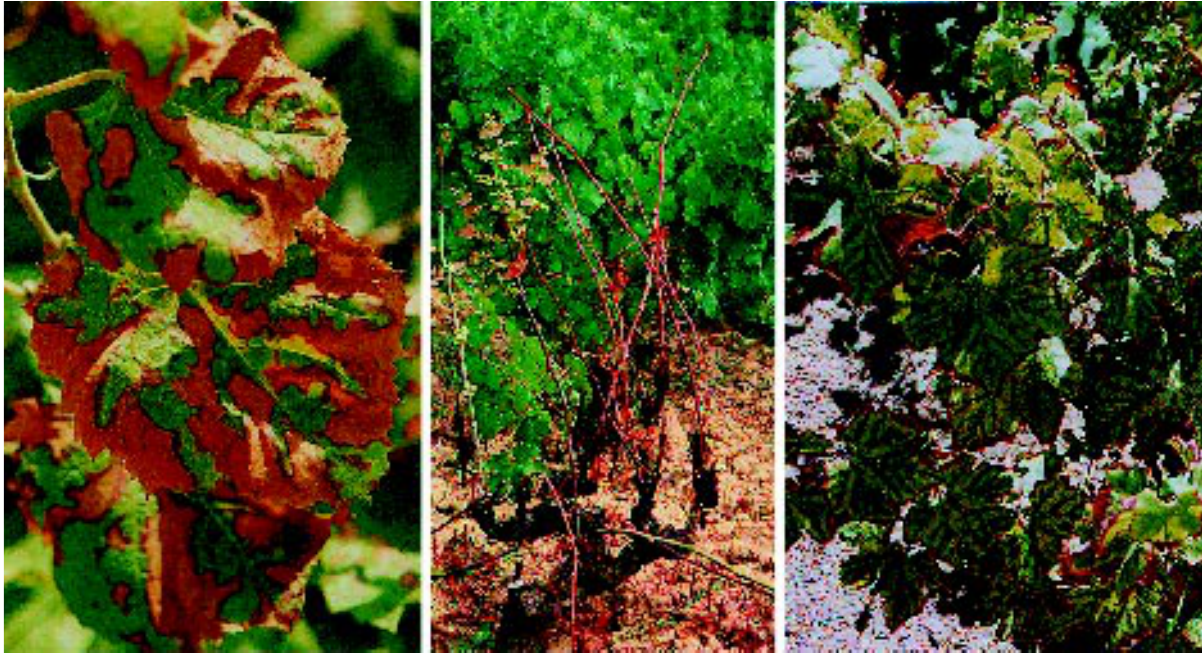
Fig. 1. Symptoms of esca on grapevine varieties grown in Thrace: leaf symptoms on an undetermined red-berried cultivar (left); apoplexy of grapevine cv. Yapincak (middle); leaf symptoms on a white-berried grapevine cv. Semillon